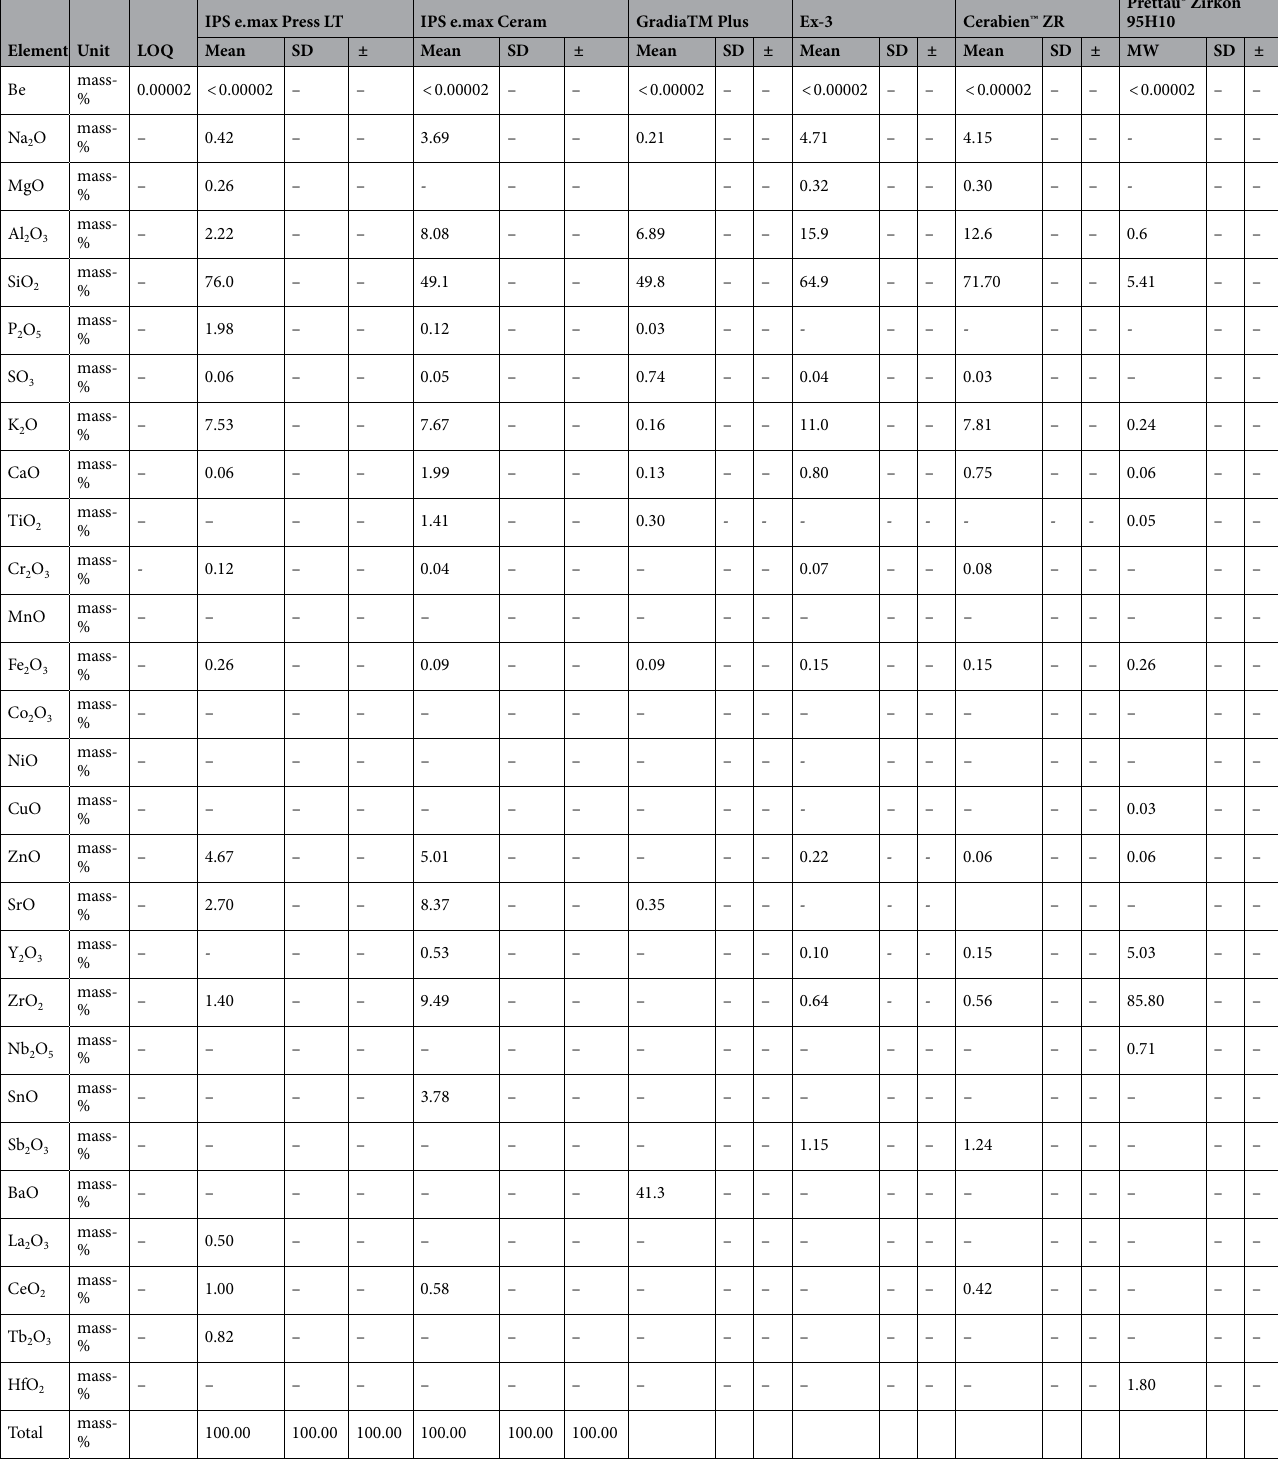
Table 7. ICP-OES results of further investigated ceramic materials. LOQ limit of quantitation, SD standard deviation, ± : measurement